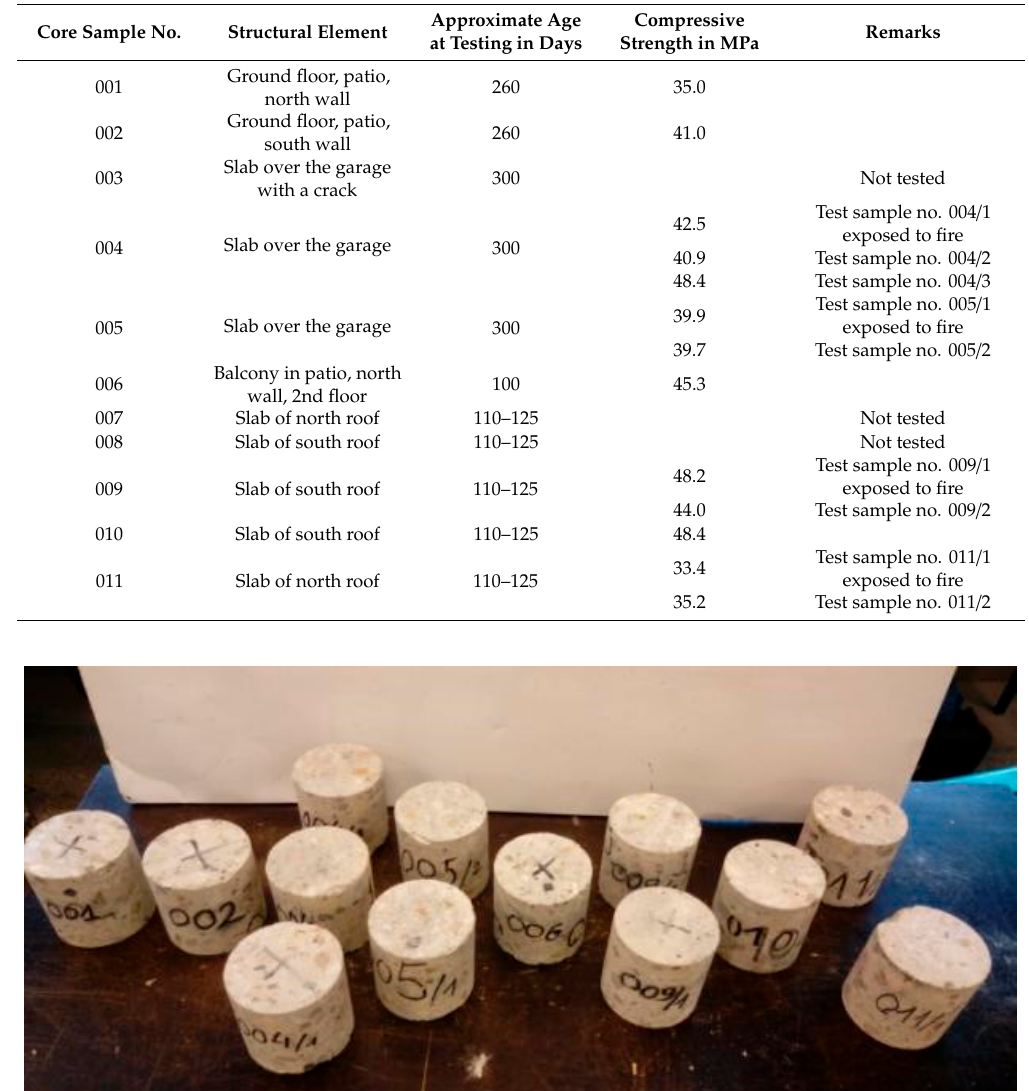
Table 2. Concrete compressive strength based on ϕ 100 / 100 mm samples.